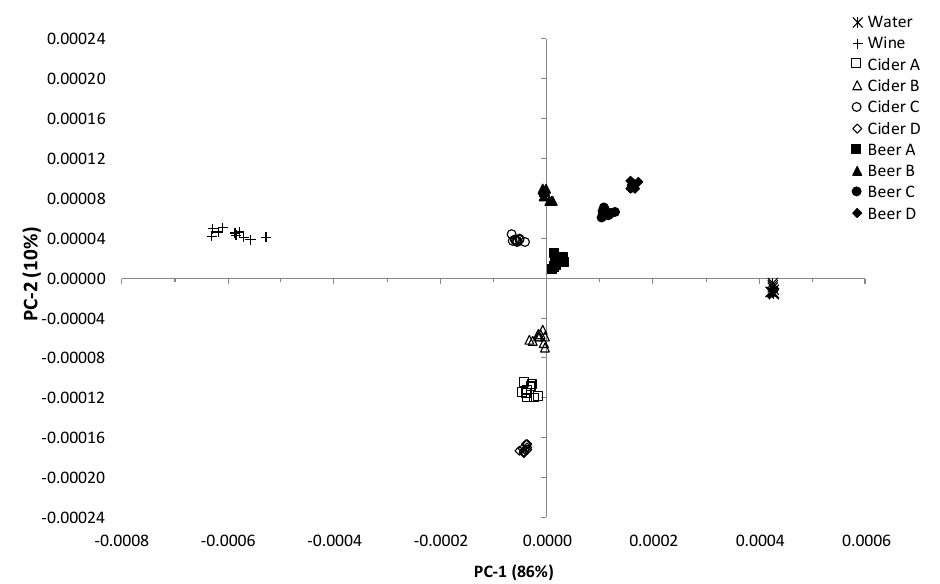
Figure 2. Score plot of the first two PCs derived from the MIR fingerprint region (1500–900 cm − 1 ) of fresh degassed carbonated beverages (ten replicates of each).